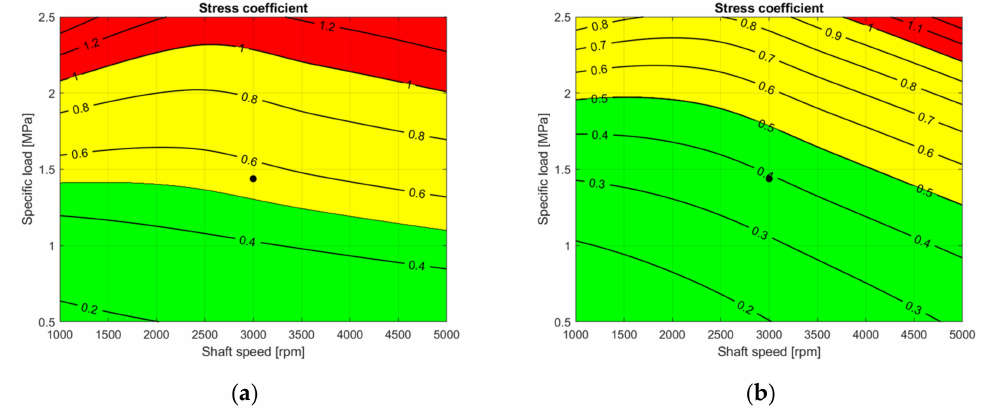
Figure 9. Operating range: ( a ) Babbitt lining and ( b ) PEEK